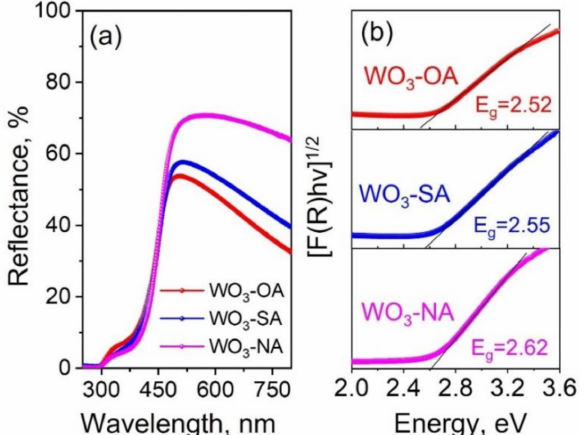
Figure 4. Diffuse reflectance ( a ) and band gap determination curves ( b ) of WO 3 prepared using different